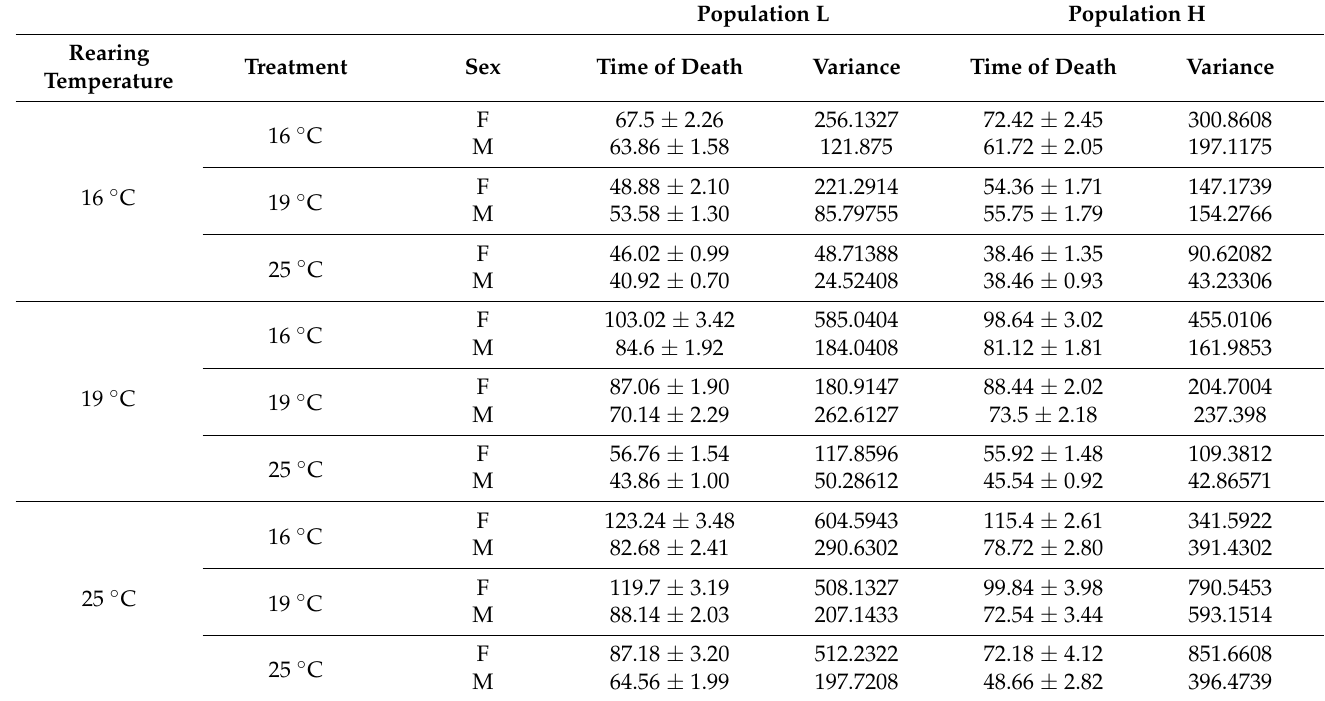
Table 3. Mean values with standard errors and variance for all groups for starvation resistance (measured in hours). Population L—population originating from lower altitude; population H— population originating from higher altitude; rearing temperature—T at which flies evolve in the laboratory; treatment—T at which flies were tested for starvation resistance; F—females; M—males; time of death—mean value ± SE (standard